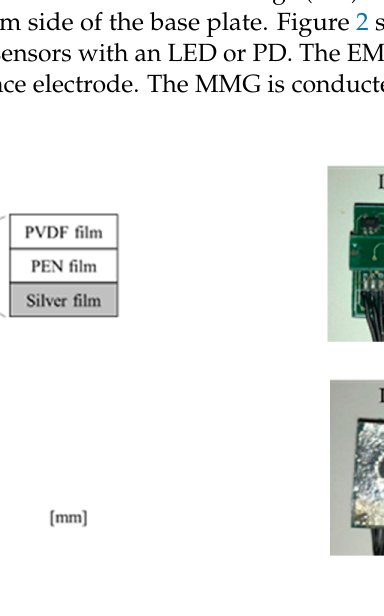
Figure 1. Multi-layered sensor: ( a ) schematic diagrams of the sensor and ( b ) photographs of sensors.